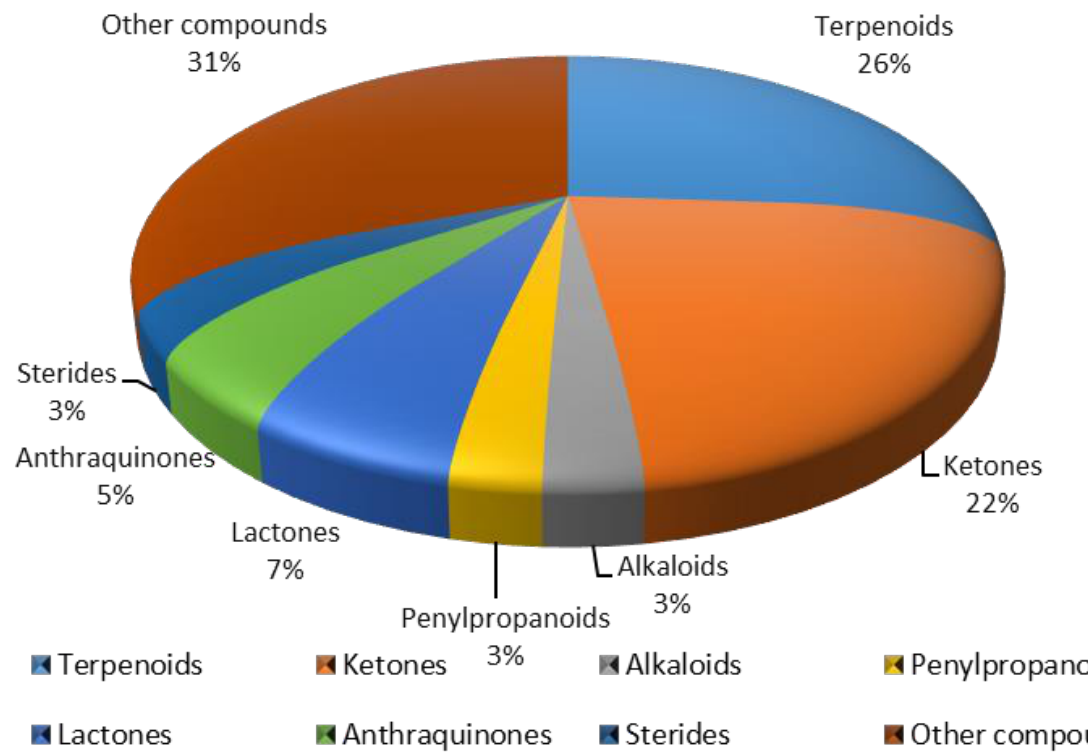
Figure 1. Percentage of metabolites synthesized by endophytes.